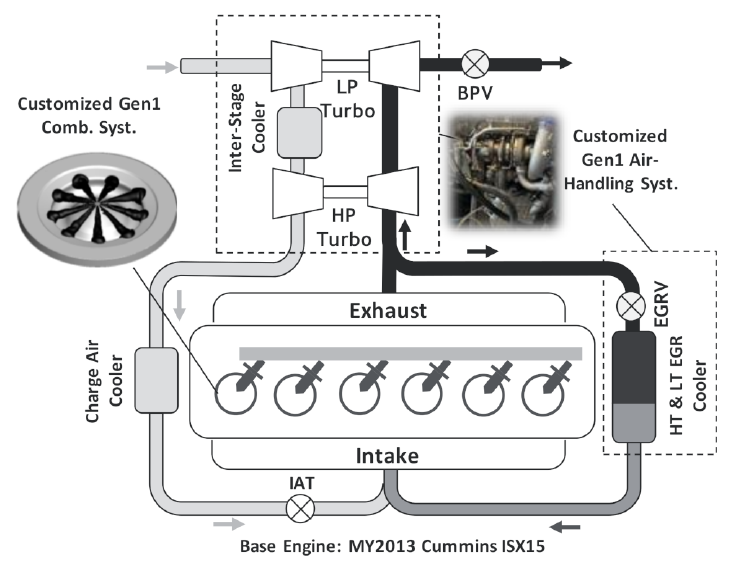
Figure 4. Gen1 GCI engine system